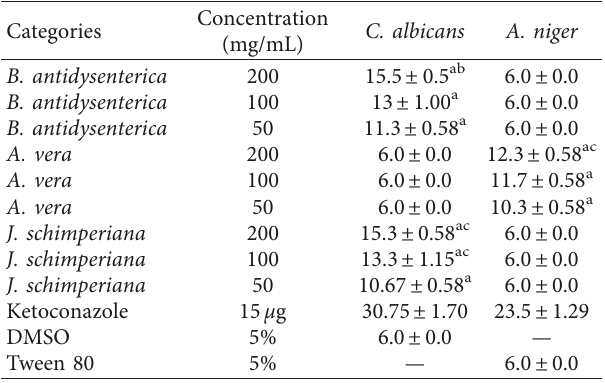
Table 3: Antifungal activity of methanolic extracts of leaves of plants against C. albicans and A.